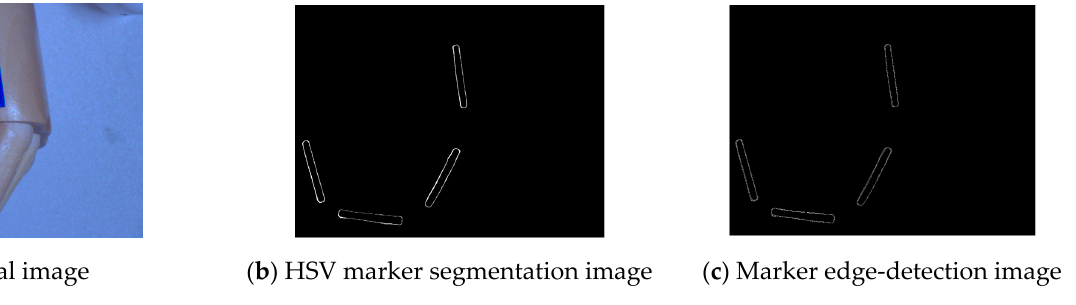
Figure 7. HSV marker segmentation and edge detection.